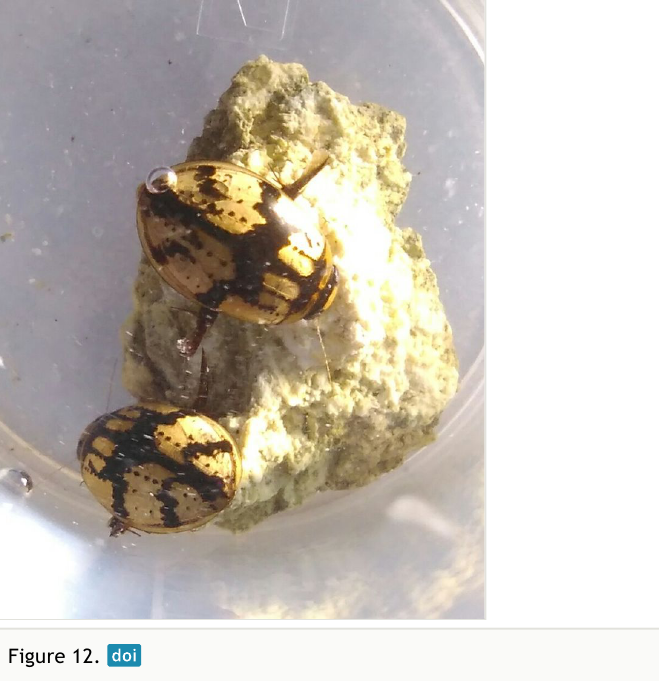
Sandracottus hunteri (Fig. 12).